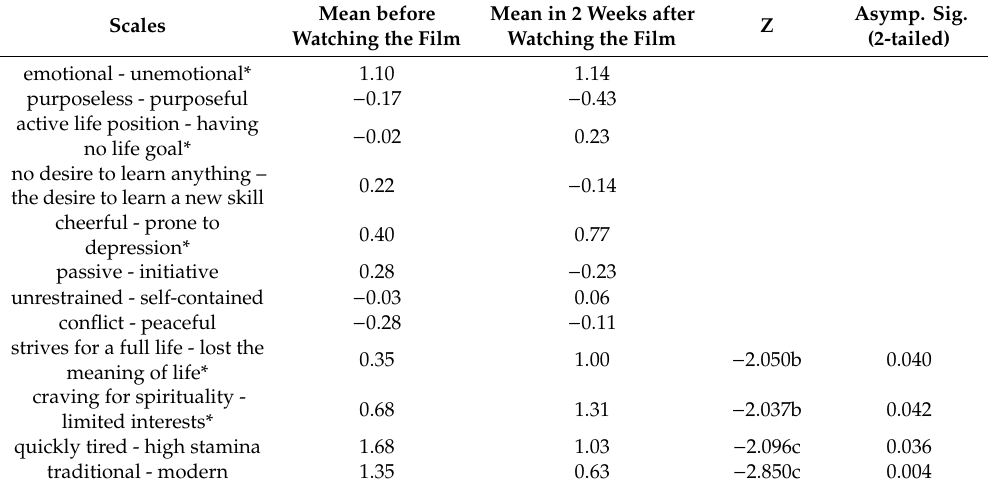
Table 4. Changes in assessments of the elderly people 2 weeks after watching the film